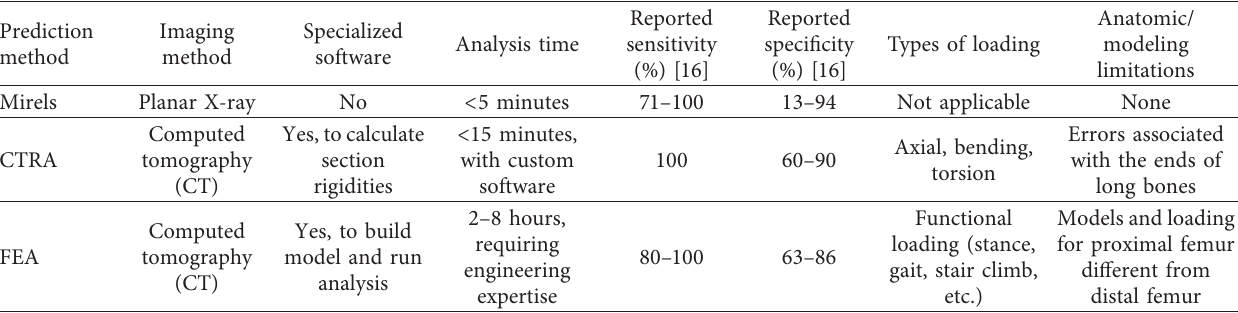
Figure 9: True negative (CTRA-/Fx-) (Case 7, R femur). This figure is for the same subject in Figure 8 but now depicts the right femur. (a) Initial X-ray imaging shows a mixed osteoblastic and osteolytic lesion in the intertrochanteric region of the right femur. (b) Both CTRA and FEA were run and neither predicted the subject to fracture. (c) Imaging taken 20 months after her initial evaluation demonstrates progression of her MBD but without Table 2: Comparison of Mirels, CTRA, and FEA technical considerations.